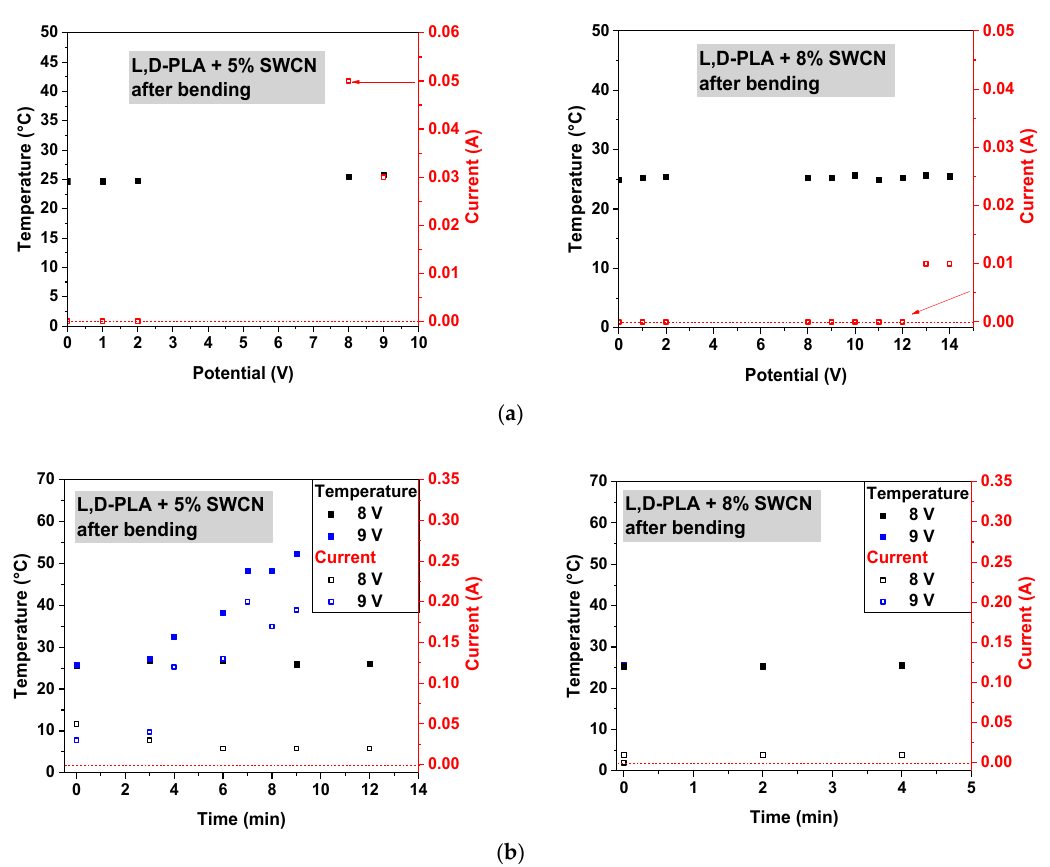
Figure 11. The correlation of temperature and current at different applied potentials ( a ) and the correlation of temperature and current over time ( b ) for films based on L , D -PLA containing 5% and 8% SWCN; after mechanical deformation.